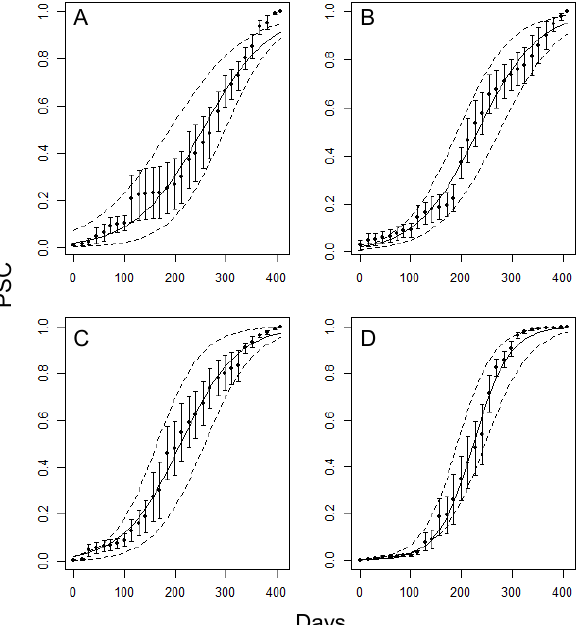
Figure 4. Proportions of the seasonal Diplodia conidia (PSC), sampled from symptomatic plants (A) or pruning debris (B), and for Lasiodiplodia from symptomatic plants (C) or pruning debris (D), in St Vicente Ferrer (Brazil), between August 2016 and October 2017. Points represent average values for four vineyards and bars represent the standard errors. Lines show the logistic equation fitted to the data (―), and its 95% confidence limits (---) (see Table 1 for pa- rameters of the four